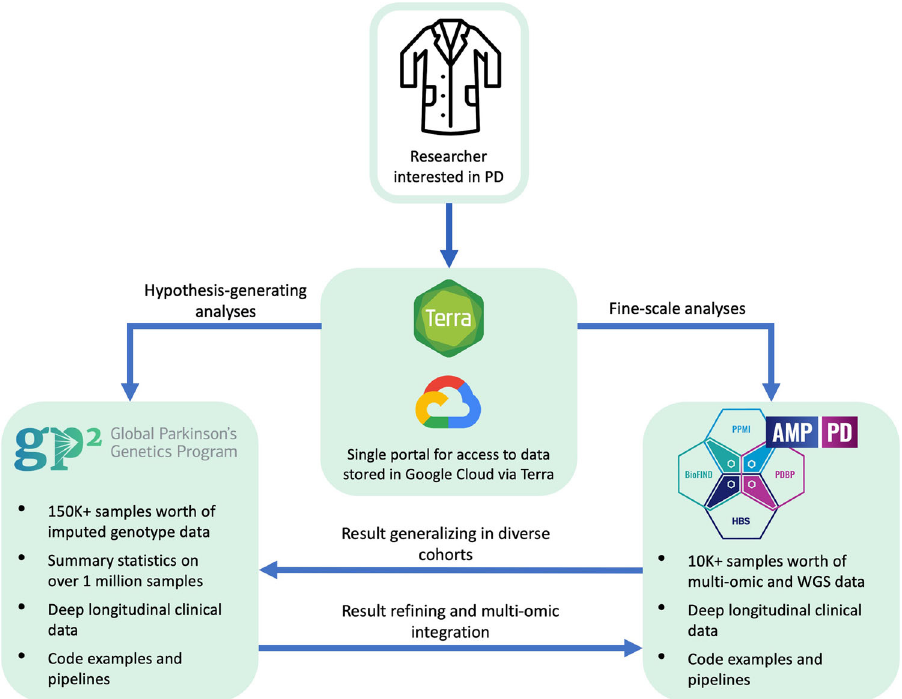
Fig. 1 The AMP PD and GP2 collaboration framework. GP2 sample numbers represented in this fi gure refer to planned numbers, not current. A single data use agreement (DUA) and the Terra cloud platform handle access to both data resources. Each resource addresses different but complementary research questions. GP2 and its wealth of diverse population genotype data were suited for large population- based and hypothesis-generating analyses. In contrast, AMP PD and its multi-omic and whole-genome sequencing data were suited for fi ne- scale